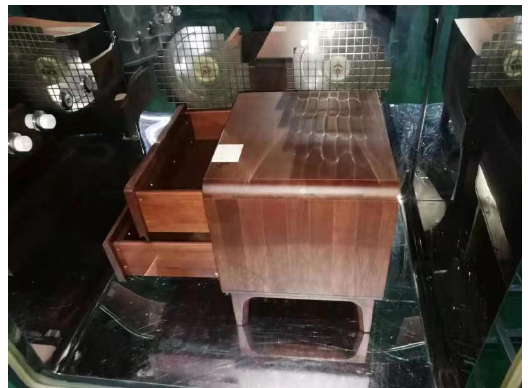
Figure 2. Schematic of the VOC emission testing system. 1-purification module; 2-heating coil; 3-cooling coil; 4-mixed box; 5-humidifier; 6-ventilator; 7-air outlet; 8-fan; 9-environmental chamber; 10- furniture; 11-heat exchanger; 12-evaporator; 13-throttle valve; 14-condenser; 15-compressor; 16-sample connection; 17-INNOVA-1412i; 18-processor.